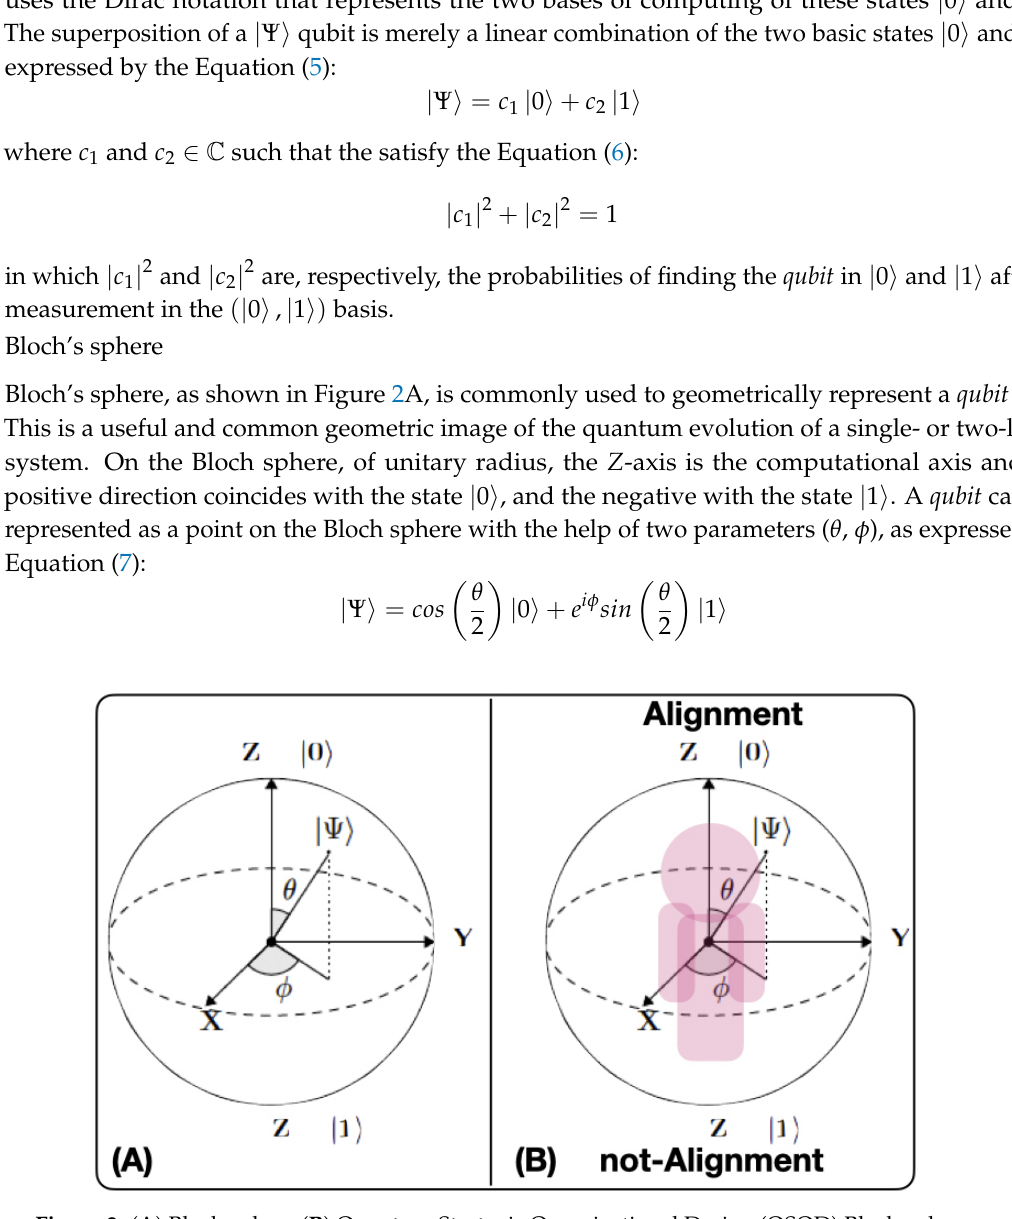
Figure 2. ( A ) Bloch sphere ( B ) Quantum Strategic Organizational Design (QSOD) Bloch